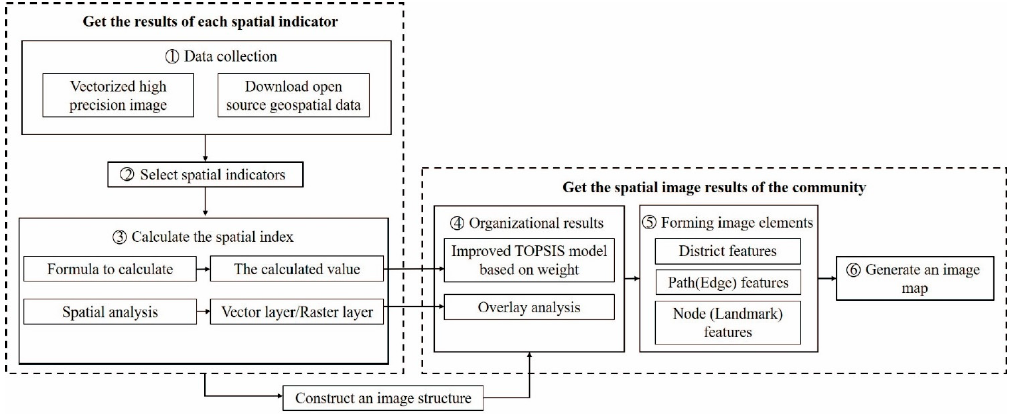
Figure 3. Modules and operating steps of the methodology.